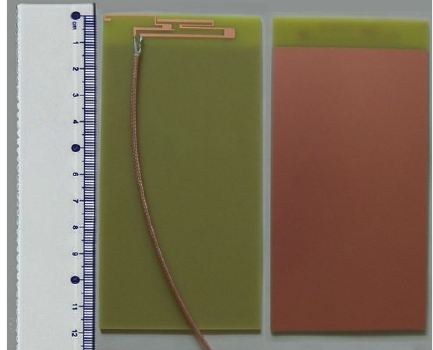
Figure 2: Photograph of the fabricated antenna with short feeding cable.